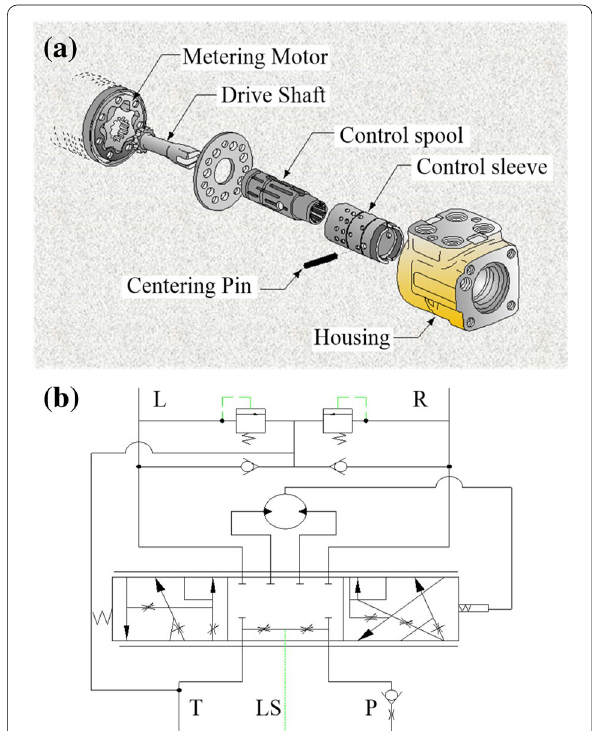
Figure 1 Schematic of the redirector: a structure of the redirector and b working principle diagram of the